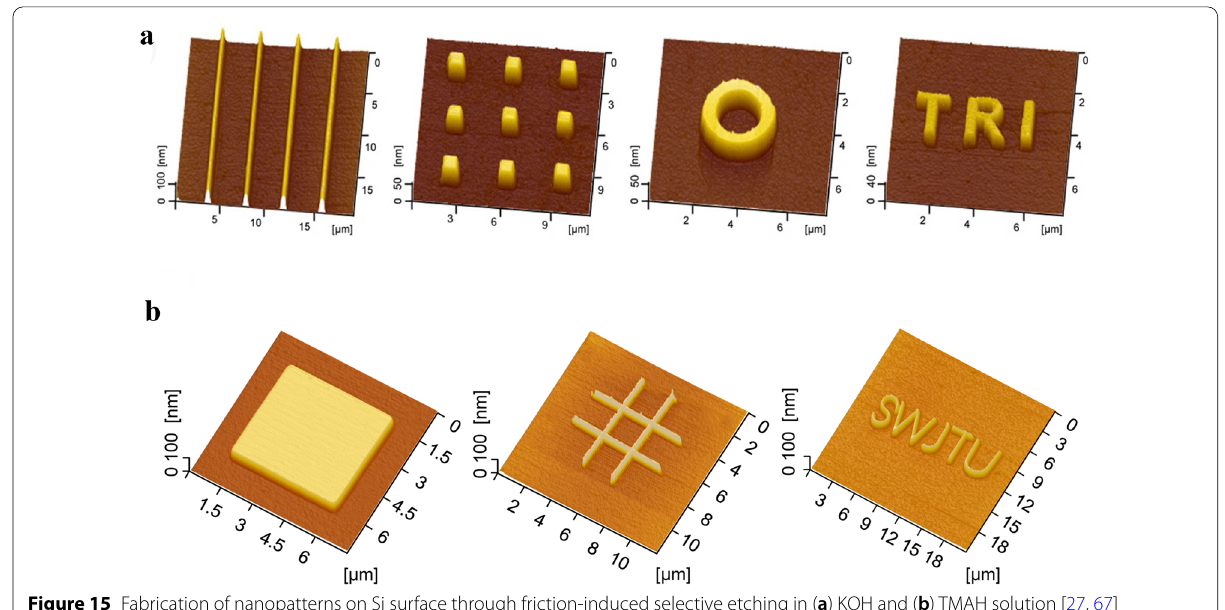
Figure 15 Fabrication of nanopatterns on Si surface through friction-induced selective etching in ( a ) KOH and ( b ) TMAH solution [27, 67]